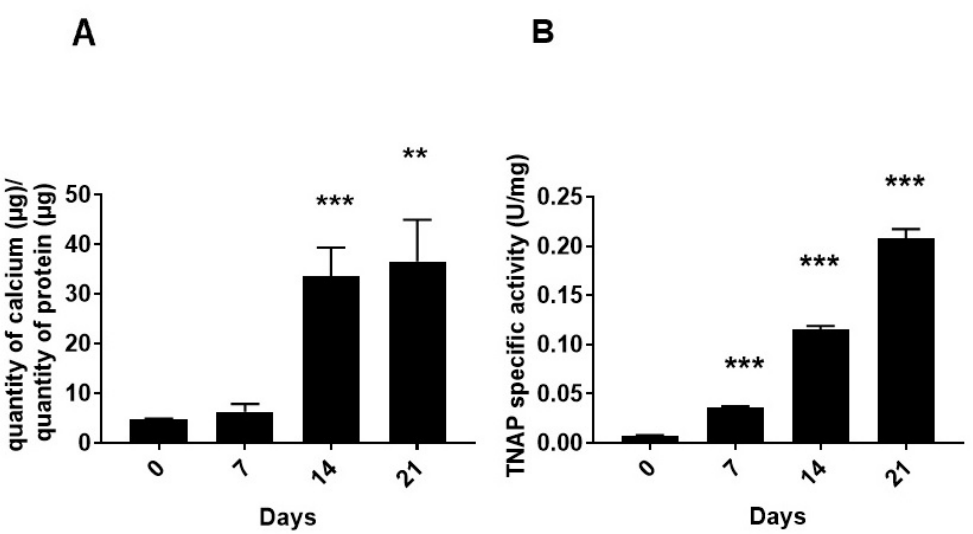
Figure 2. Characterization of the murine aortic smooth muscle cell line (MOVAS) during the transdifferentiation in osteogenic medium containing 50 µg.mL −1 of ascorbic acid and 10 mM of β-glycerophosphate. ( A ) Relative amount of calcium expressed as µg calcium per µg protein in calcium phosphate precipitates induced by MOVAS cells at the indicated incubation time in osteogenic medium ( n = 6). ( B ) Tissue non-specific alkaline phosphatase activity in MOVAS cells at the indicated incubation time in osteogenic medium ( n = 6). Results were considered highly significant when p < 0.01 (**), and extremely significant when p < 0.001 (***).